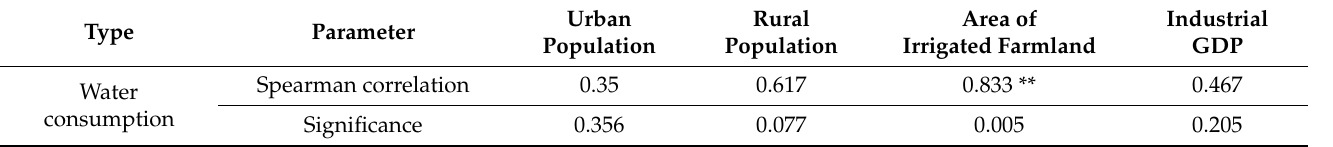
Table 3. Spearman correlation of influencing factors of water consumption simulation in the Jinjiang watershed.